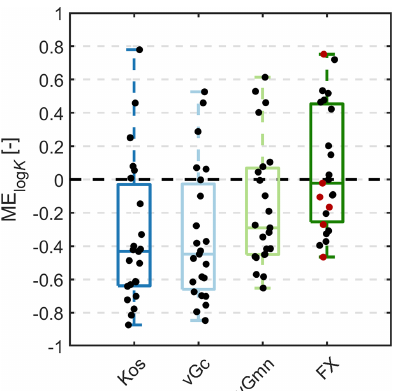
Figure 6. Mean errors of the predicted absolute conductivity based on the soil water retention function for 23 test data sets. Black dots indicate all 23 validation data sets; red dots indicate data sets shown in Fig.